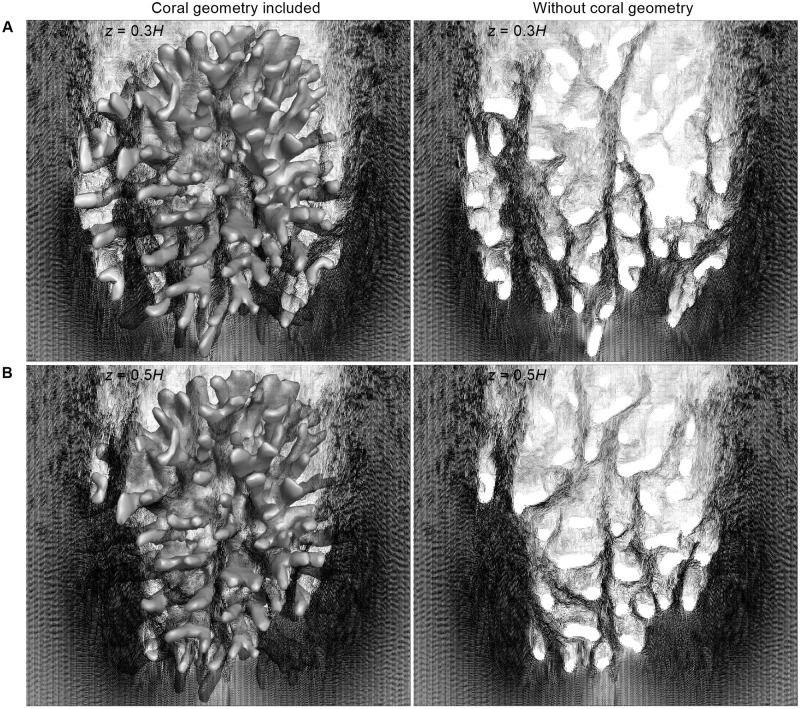
Top view of velocity vector field at two different heights inside the P. eydouxi colony, with and without the coral geometry.(A) The vector field obtained at a height of z = 0.3H with the coral colony geometry included in the image (left) and without the geometry (right). (B) The vector field obtained at a height of z = 0.5H with the coral colony geometry included in the image (left) and without the geometry (right). The figures show the formation of wakes behind the individual branches in the colony, and better flow penetration can be seen at the interior of colony compared to P. meandrina.